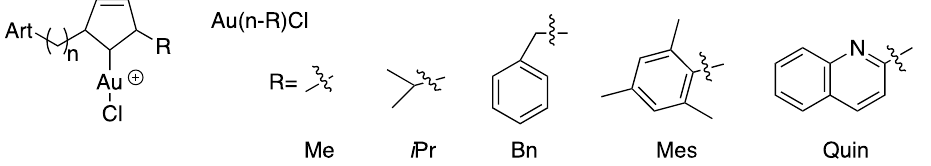
Figure 6. Dihydroartemisinin derivatives and gold(I)- N -heterocyclic carbene (NHC) complexes.